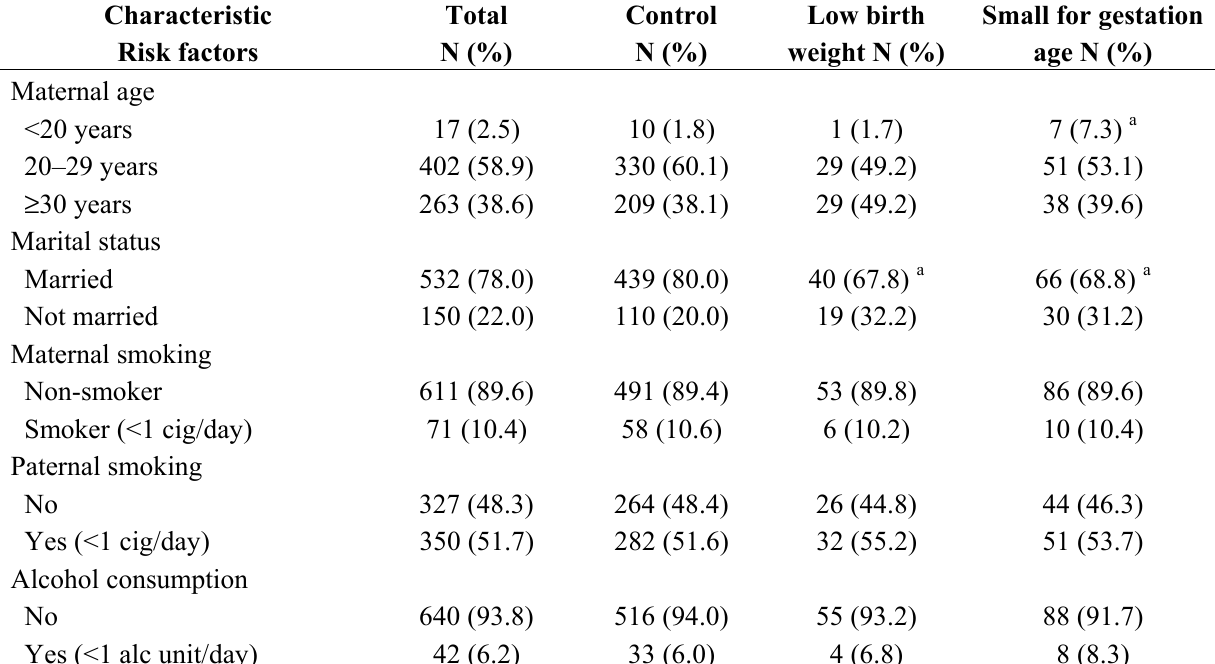
Table 1. Percent distribution of low birth weight and small for gestational age by maternal characteristics and p value of chi